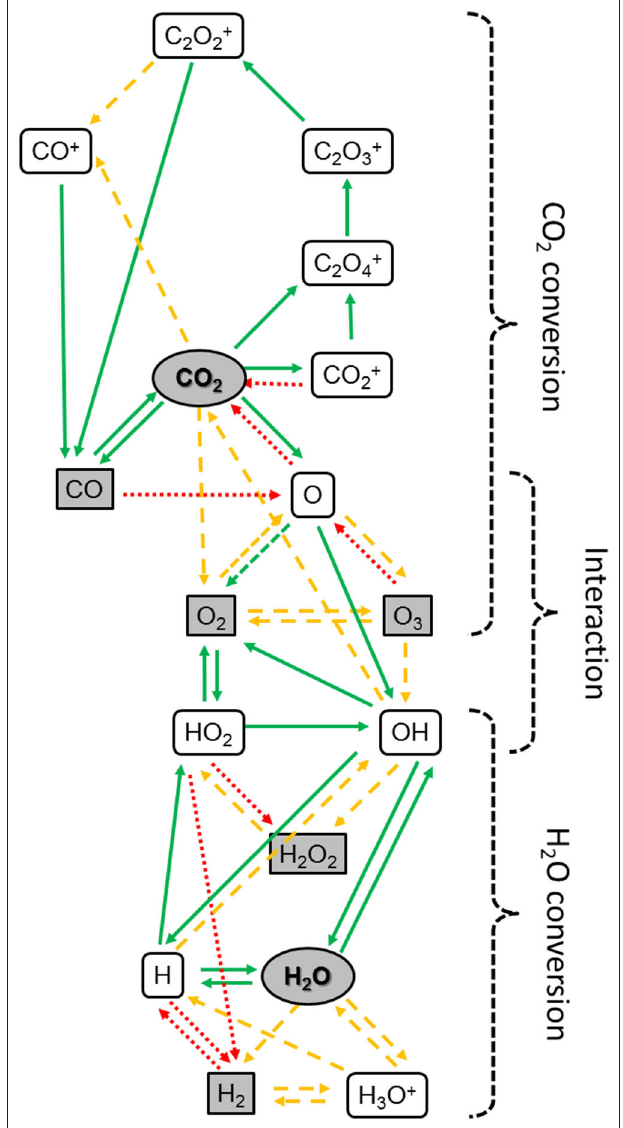
FIGURE 14 | Main reaction pathways for CO 2 and H 2 O conversion in a DBD plasma. The arrow lines denote the formation rates of the species, with full green lines being formation rates over 10 17 cm − 3 · s − 1 , orange dashed lines between 10 17 and 10 16 cm − 3 · s − 1 and red dotted lines between 10 16 and 10 15 cm − 3 · s − 1 . Adopted from Snoeckx et al. (2017) with